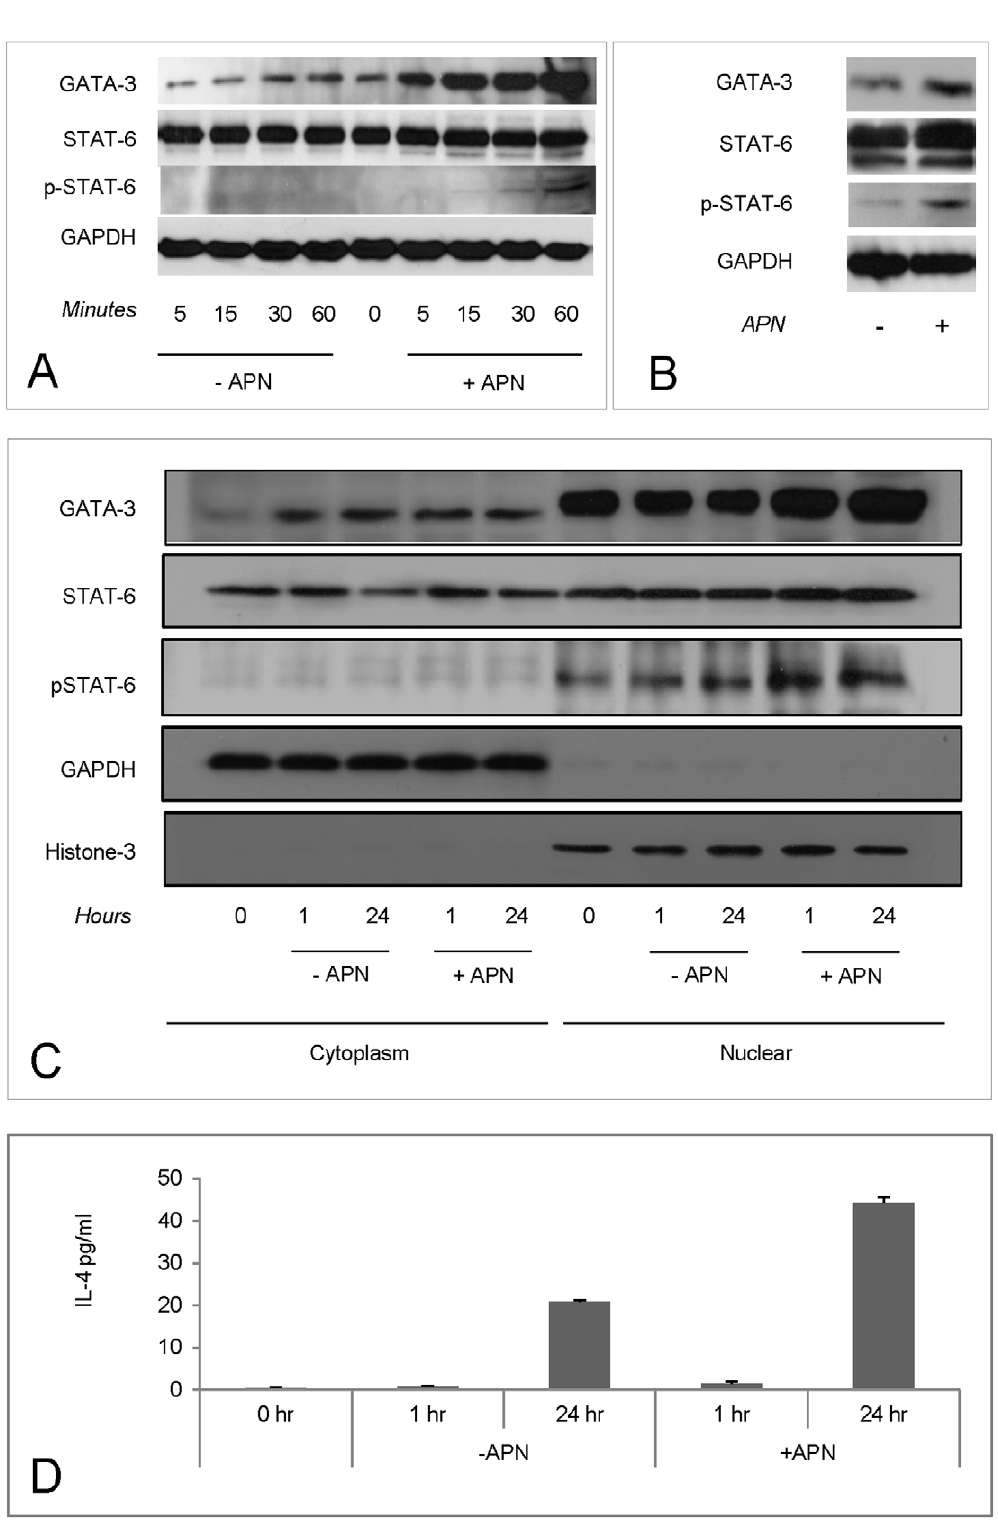
Figure 5. GATA-3 and STAT6 expression in response to Adiponectin (APN). Intracellular signaling pathways for IL-4 production were detected using the IL-4 producing T cell line EL-4. Cells were cultured in RBMI medium with 2.5% fetal bovine serum. The APN (5 m g/ml) was added and the samples were collected with the indicated time points (n=3). The expression of GATA-3 and STAT6 was detected in whole lysates (A and B) or separated cytoplasmic and nuclear parts (C and D) using Western blot. The expression of IL-4 was detected in supernatants with ELISA.